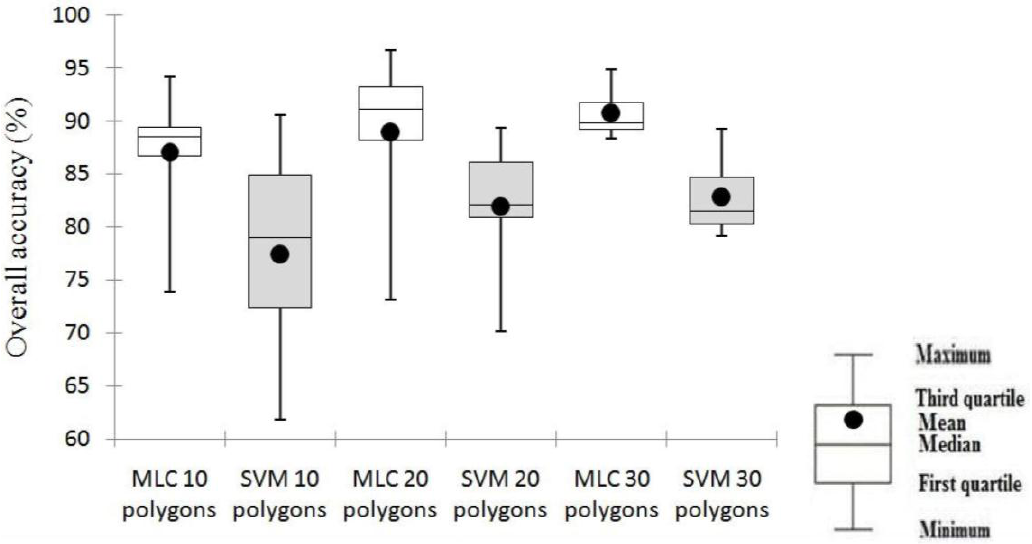
Figure 4. Boxplots showing the overall accuracy of Maximum Likelihood (MLC) and Support Vector Machine (SVM) classification techniques using 10, 20 and 30 polygons/sample sizes. The horizontal line in each of the boxes is the median, the black dot is the mean, the boxes are the first and third quartiles and the whiskers are the minimum and maximum